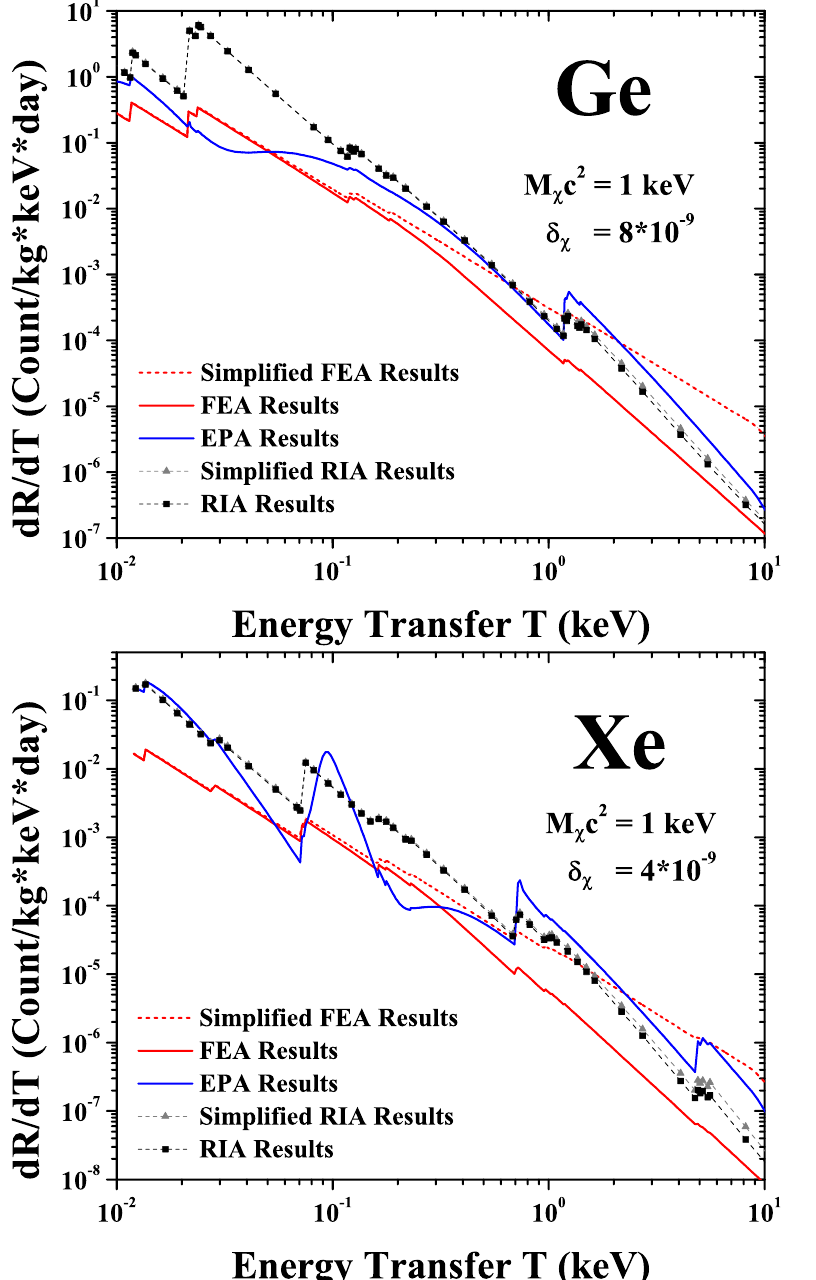
Figure 6 . The differential reaction event rates for atomic ionization process induced by millicharged particles. The mass of millicharged dark matter particle is set as m 2 = 1 keV, and its millicharge χ c is chosen to be δ = 8 × 10 − 9 for HPGe detector and δ = 4 × 10 − 9 for LXe detector, respectively. χ χ In this figure, the horizontal axis represents the energy transfer T , and the vertical axis represents the differential event rate dR/dT in unit of cpkkd. The red solid lines correspond to the FEA results; red dashed lines represent the simplified FEA results; blue lines stand for the EPA results; black squares display the RIA results; gray triangles show the simplified RIA